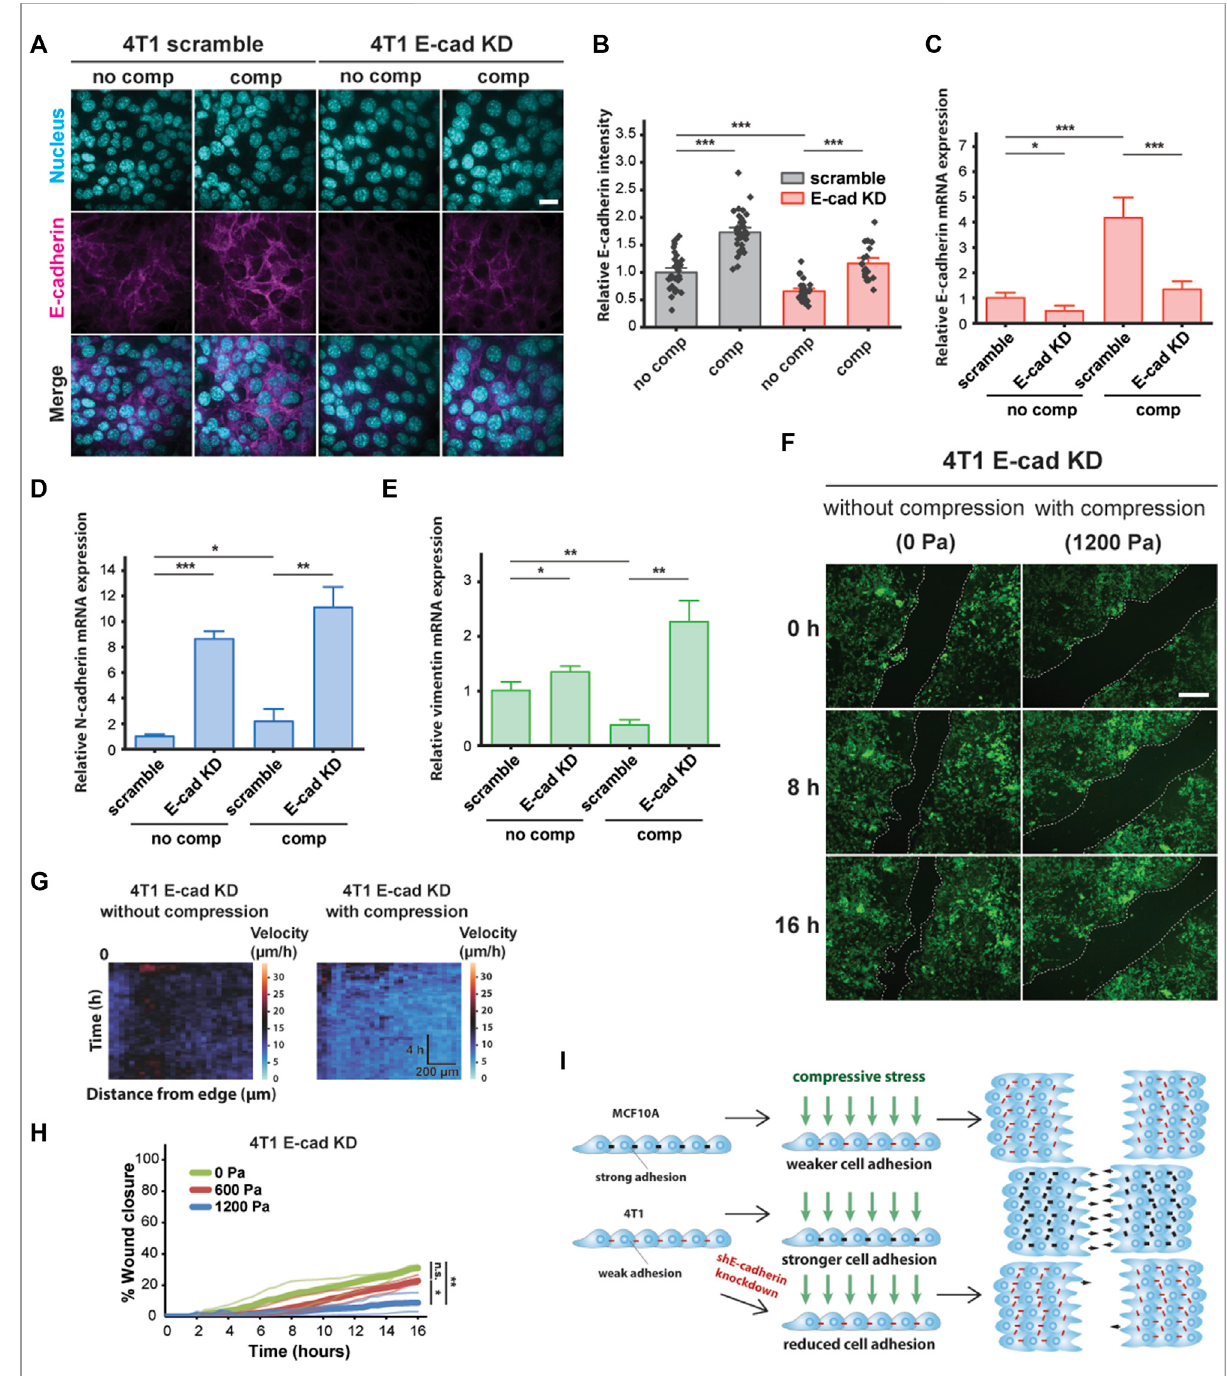
FIGURE 4 E-cadherin knockdown inhibited compression-induced upregulation of E-cadherin in 4T1 cells, triggering jamming. (A) Representative microscopyimagesof4T1scrambleandE-cadKDcellslabeledwithDAPIandanE-cadherinantibody.E-cadKDisinducedin4T1shE-cadherincells by adding 200 μ MIPTG 72 h prior to experiments. Cell monolayers are exposed to speci fi ed stresses for 12 h. Scale bar, 20 µm. (B) Quanti fi cation of relative E-cadherin fl uorescence at the cell – cell contacts of 4T1 scramble and E-cad KD cells. Mean fl uorescence intensity at the cell membrane ±S.E. is plotted from three independent replicates ( n = 22 – 36). qPCR analysis of E-cadherin (C) , N-cadherin (D) , and vimentin (E) mRNA levels in 4T1 scramble and E-cad KD cells. Transcript levels are calculated using the ΔΔ C t method normalized to GAPDH. Mean mRNA level ±S.E. is plottedfromthreeindependentexperimentswithduplicatesperexperiment. (F) Representativeimagesof4T1E-cadKDwoundareaattheindicated time points post-wound. 4T1 shE-cadherin cells express mNeonGreen. Cell edges used to calculate wound area are outlined by white dashed lines. Scale bar, 200 µm. (G) Heat maps of spatiotemporal evolution of the velocity for 4T1 E-cad KD cells under different levels of mechanical